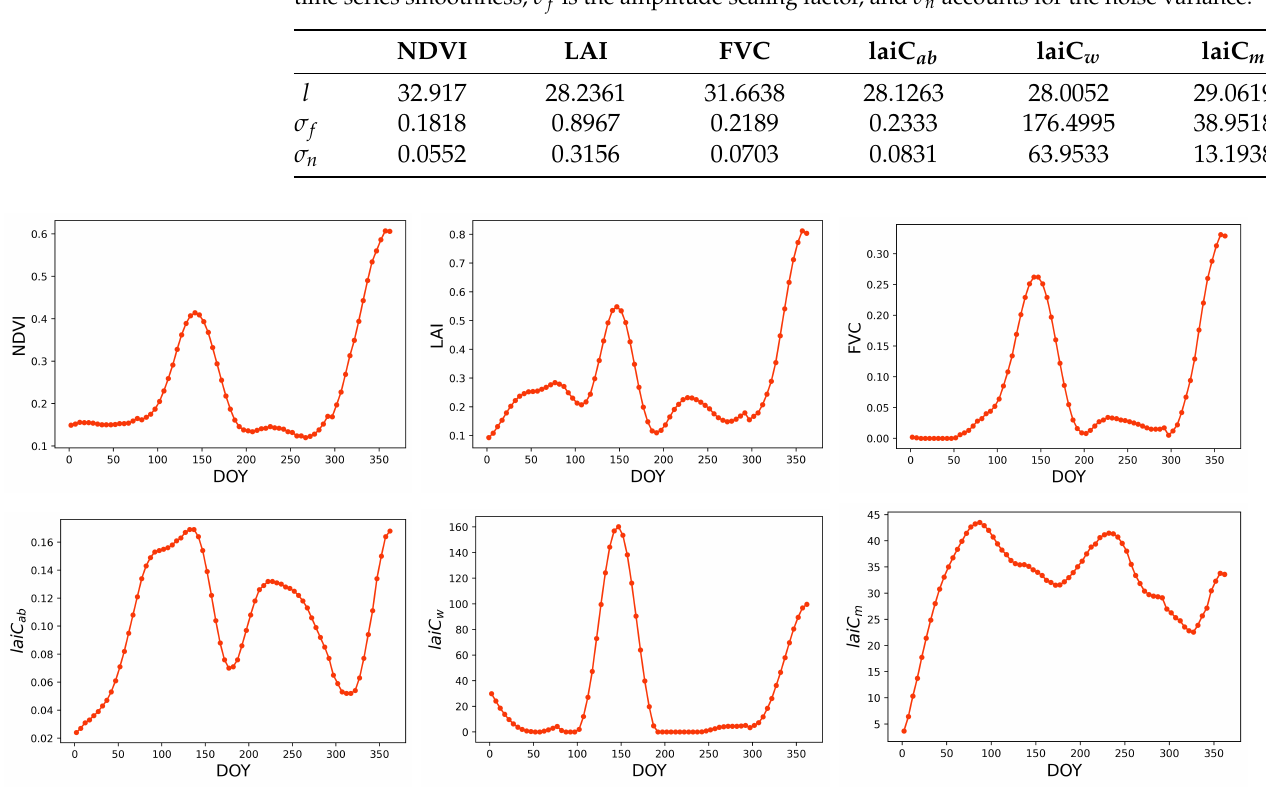
Table A2. Averaged hyperparameters estimated using the global approach: l defines the gap-filled time series smoothness, σ f is the amplitude scaling factor, and σ n accounts for the noise variance.